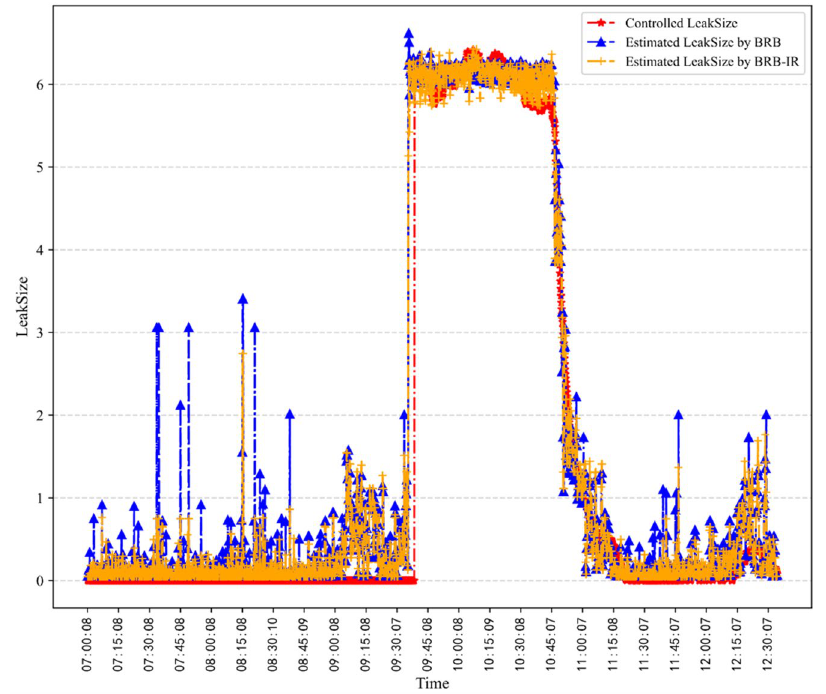
Figure 8. Estimated LeakSize by the classical BRB and